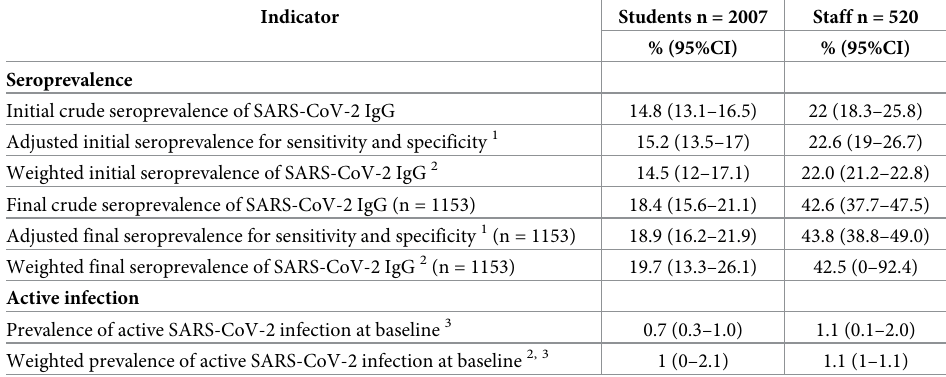
Table 5. Summary of crude and adjusted seroprevalence and active infections during the first trimester of 2021 in sentinel school project, Catalonia, Spain.